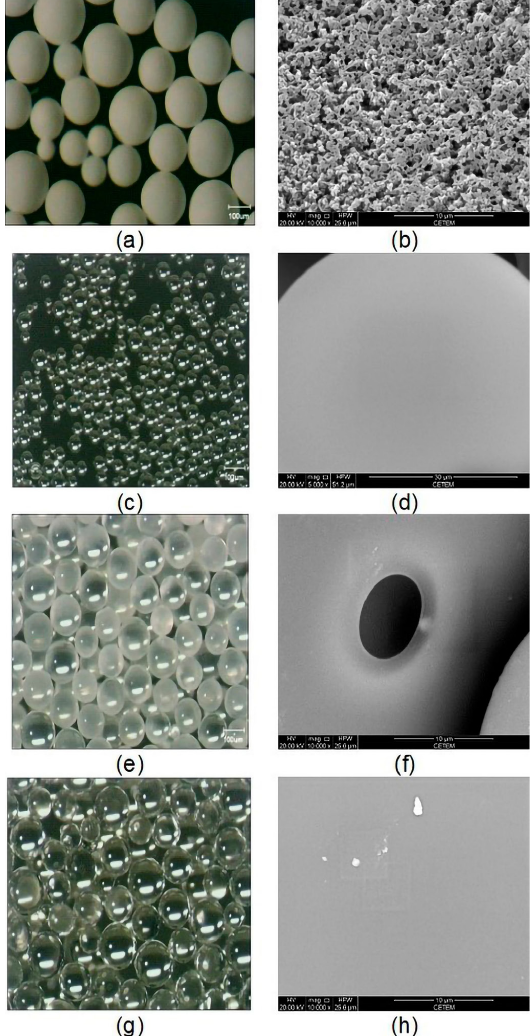
Figure 3. Optical (OM) and scanning electron (SEM) microscopic images of the copolymers P-01 OM: (a), SEM: (b); P-02 OM: